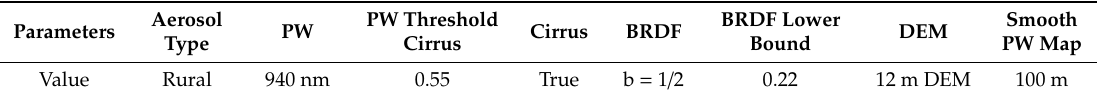
Table 2. Key parameter settings for the topographic standardization of S2 images in Sen2Cor. BRDF: bidirectional reflectance distribution